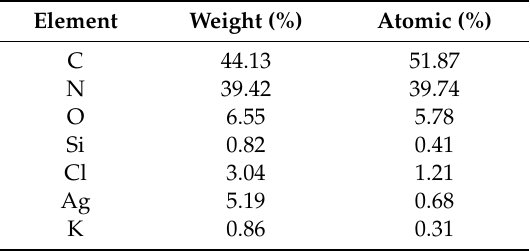
Figure 1. ( A ) FESEM image and ( B ) EDX analysis of the catalyst. Table 1. The quantitative results of EDS analysis.